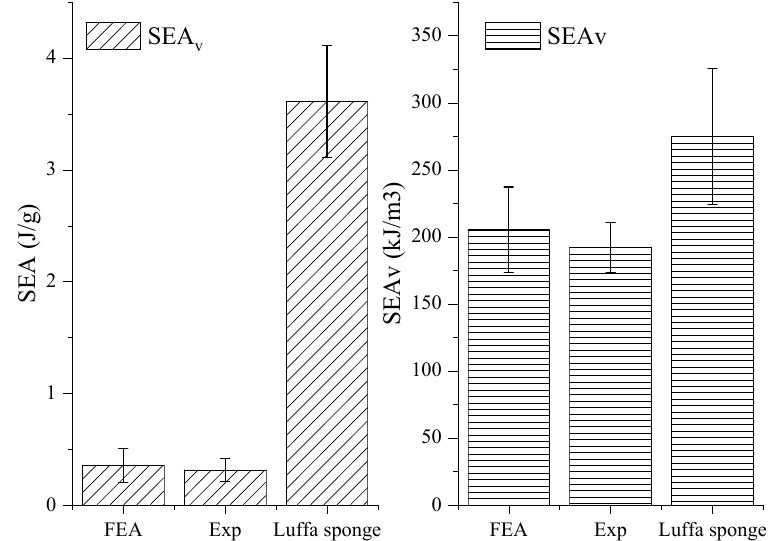
η ) between FEA, experiment and luffa sponge.